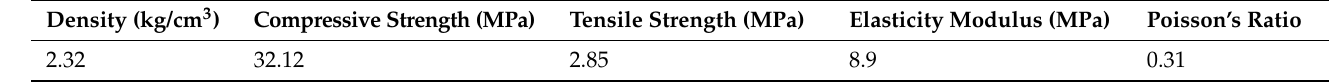
Figure 1. Sandstone specimen ( a ) and rough fracture surface ( b ). Table 2. Physical and mechanical parameters of sandstone specimens. Table 2. Physical and mechanical parameters of sandstone specimens.